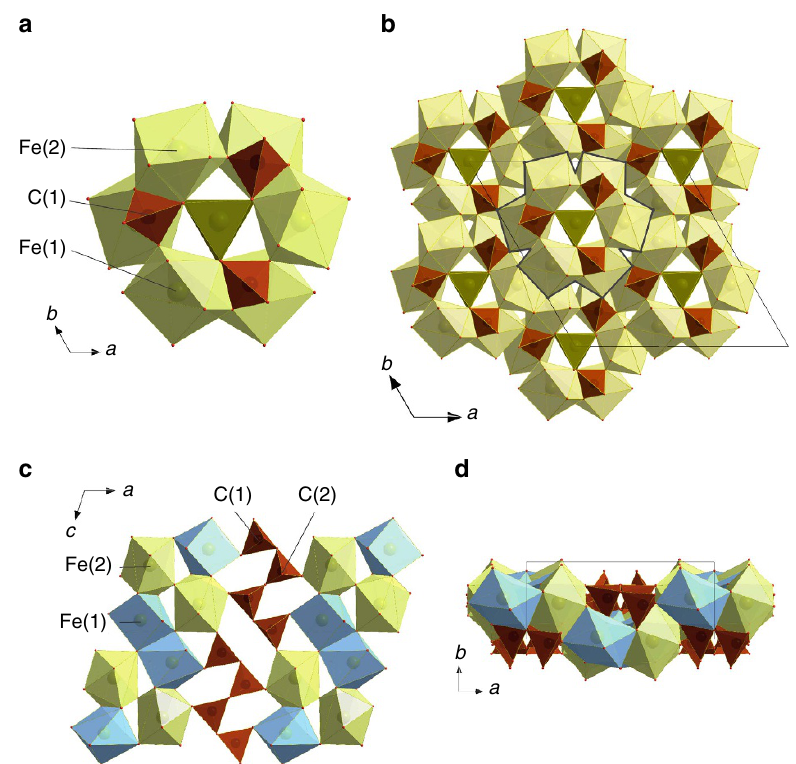
Figure 2 | Crystal structures of high-pressure carbonates. ( a , b ) Tetrairon(III) orthocarbonate Fe 4 C 3 O 12 and ( c , d ) diiron(II) diiron(III) tetracarbonate Fe 4 C 4 O 13 , at ambient temperature and 74(1) and 97(2) GPa, respectively. In a , three FeO8 bicapped prisms (light green) and three CO 4 (cid:2) tetrahedra (brown) form a ring with threefold symmetry by corner and edge sharing. The rings form layers that are stacked along the c axis. FeO6-prisms (dark green) are connected by triangular bases and located in the channels created by the rings. In b the overall structure of the orthocarbonate is displayed along the c -axis. In c FeO8 bicapped prisms (light green) are connected in a 3D framework by dimers of edge-shared FeO7 monocapped prisms (blue) and zigzag-shaped C 4 O 13 10 (cid:2) chains (brown) shown along the b axis. In d the tetracarbonate structure is displayed along the c